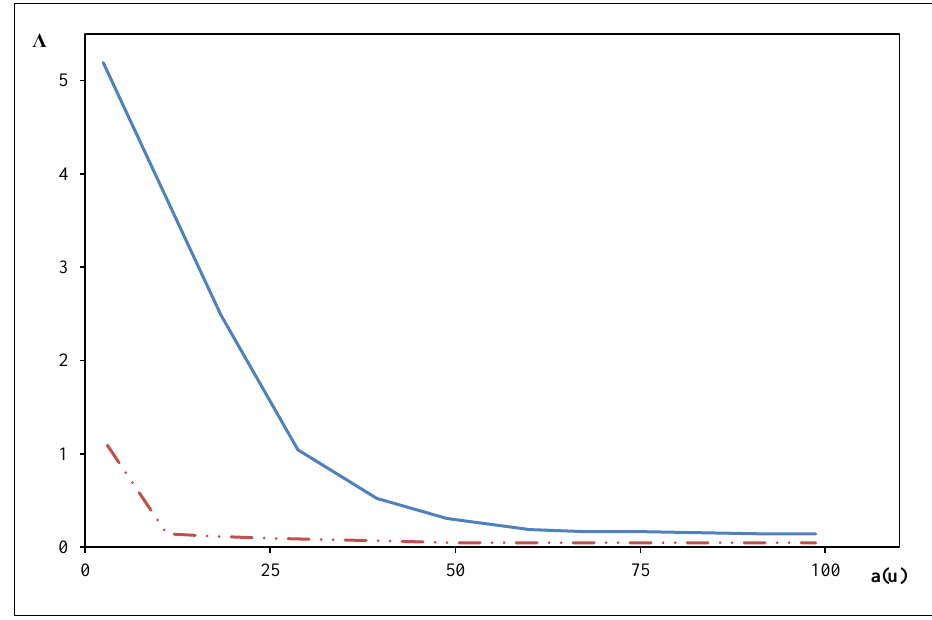
Figure 19. Graphs showing the dependence of information loss on the number of descriptors (for two contours)